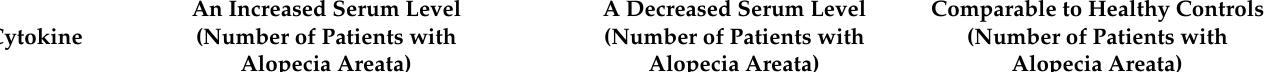
Comparable to Healthy Controls A Decreased Serum Level (Number of Patients with (Number of Patients with Alopecia Alopecia Areata)